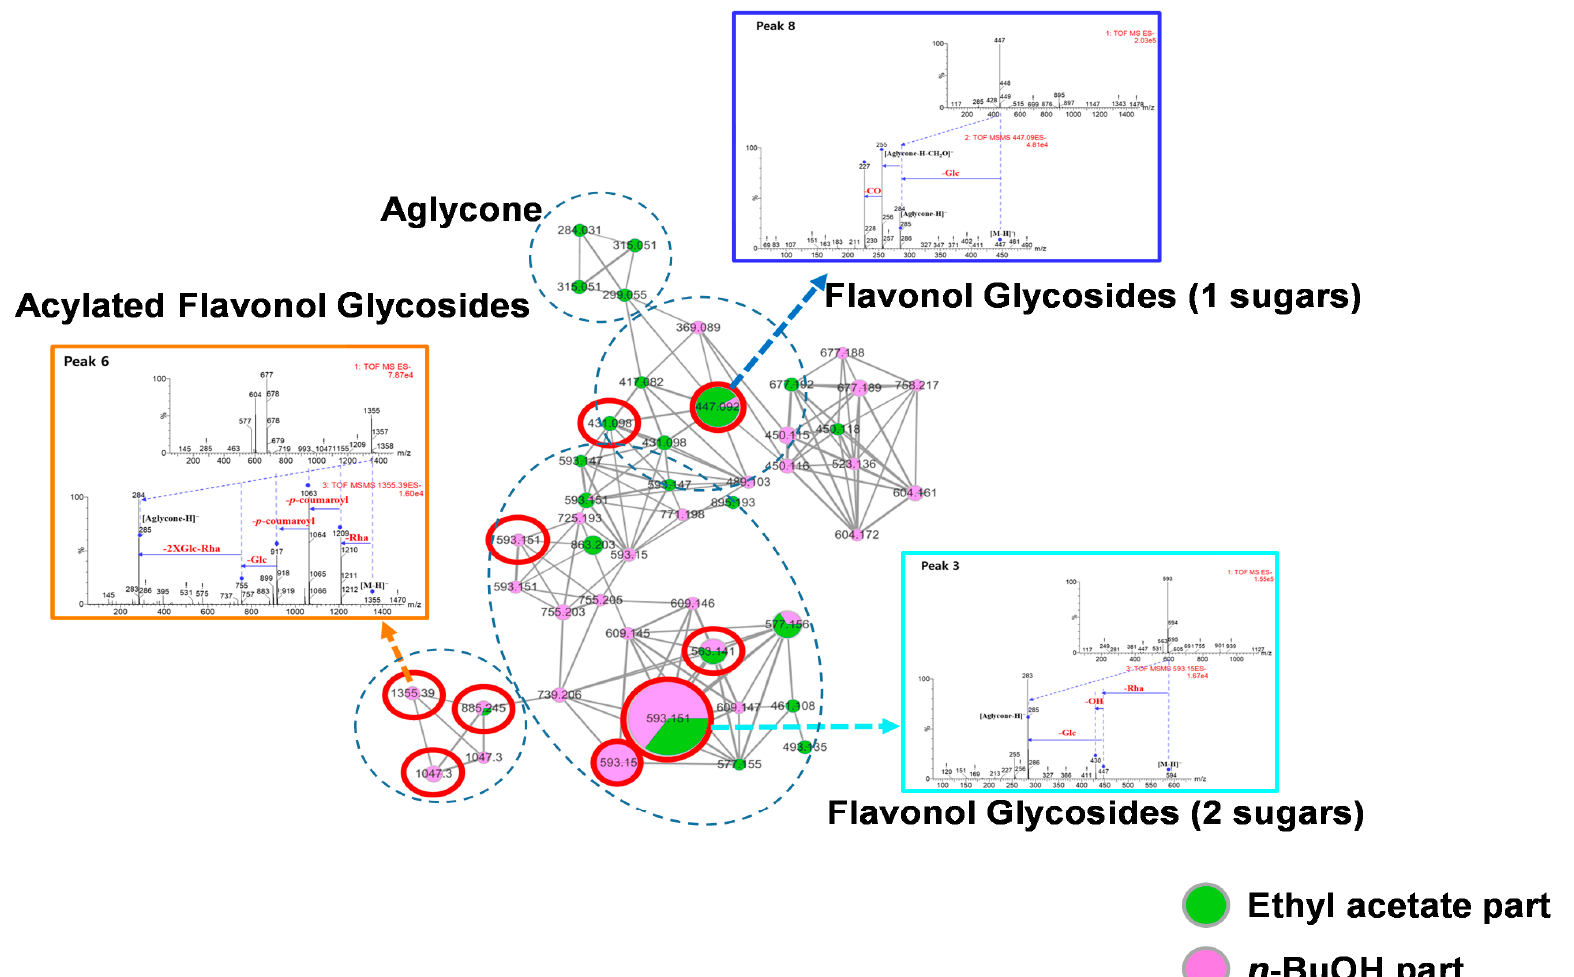
Figure 1. Bioactive molecular networking of the ethyl acetate (green cluster) and n -BuOH (pink cluster) soluble fractions of the N. lappaceum seed extract. Detailed conditions for molecular networking were provided in the Supplementary Materials (Figure S41).